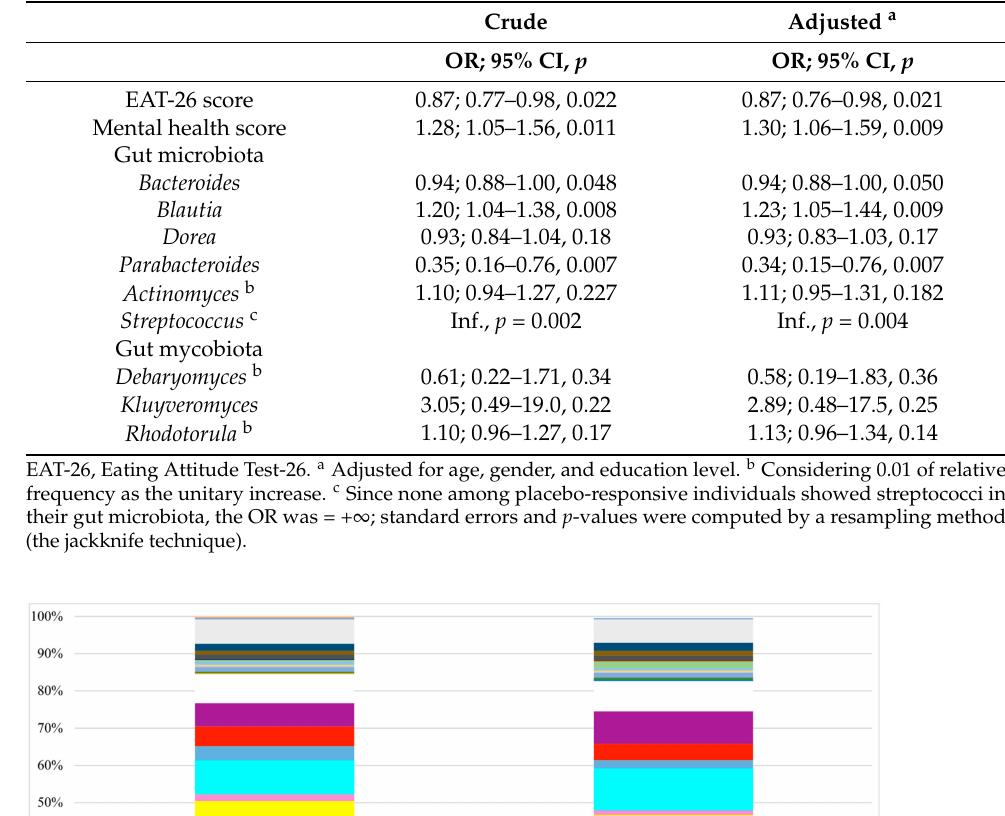
Table 3. Association between the positive response to the DBPC gluten challenge and different variables in a multiple logistic regression model.